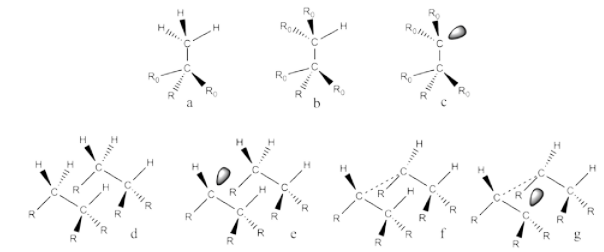
Figure 3. Sites from models 2 and 3: а-c — evolution of sites in model 2: CH 3 , CH, C; d-g — evolution of sites from CH 3 to С in model 3, R denotes the carbon atom inserted into the diamond, R 0 — R, C-containing radical or H.